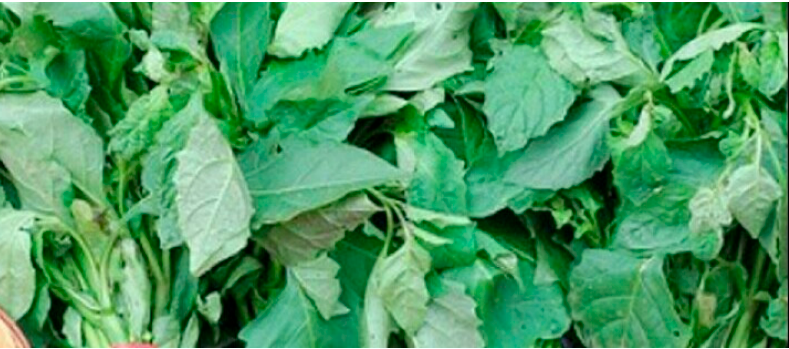
Figure 2. Vernonia amygdalina (bitter leaf).